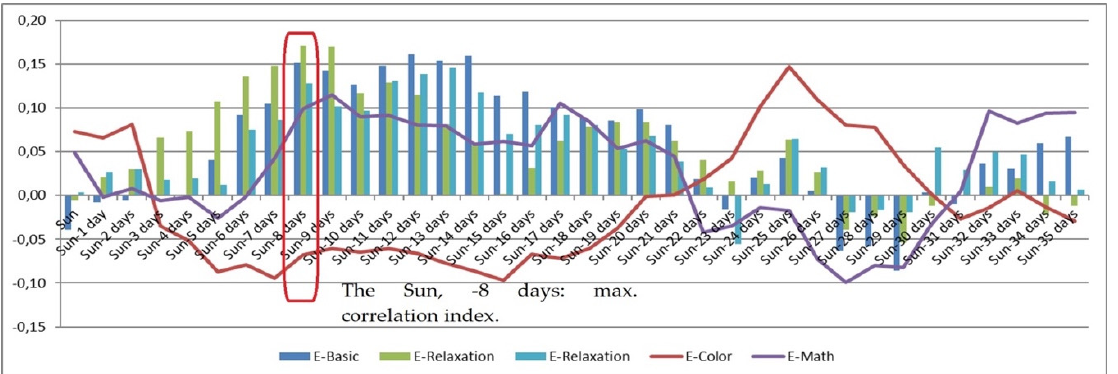
Figure 4. The correlation dependency of the psychophysiological parameter B (BVP peak freq. mean (Hz) (HRV)) on the intensity of solar activity.